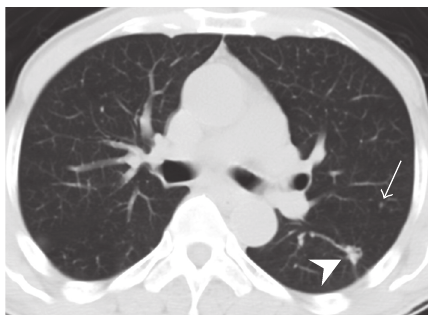
Figure 1: Axial chest computed tomography scan at subcarinal level demonstrates a 4.5 mm ground-glass opacity nodule in left upper lobe of lung (arrow) and a 16mm part-solid ground-glass nodule in left lower lobe of lung (arrowhead). They are proved to be a pulmonary meningioma in left upper lobe of lung and granulomatous inflammation in left lower lobe of lung in histologic diagnosis,